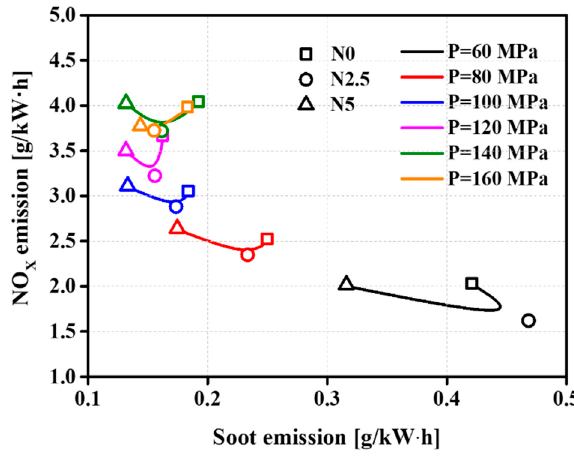
Figure 14. Soot–NOX relationship of n -octanol/diesel blends with different injection pressures. Figure 14. Soot–NO X relationship of n -octanol/diesel blends with different injection pressures.